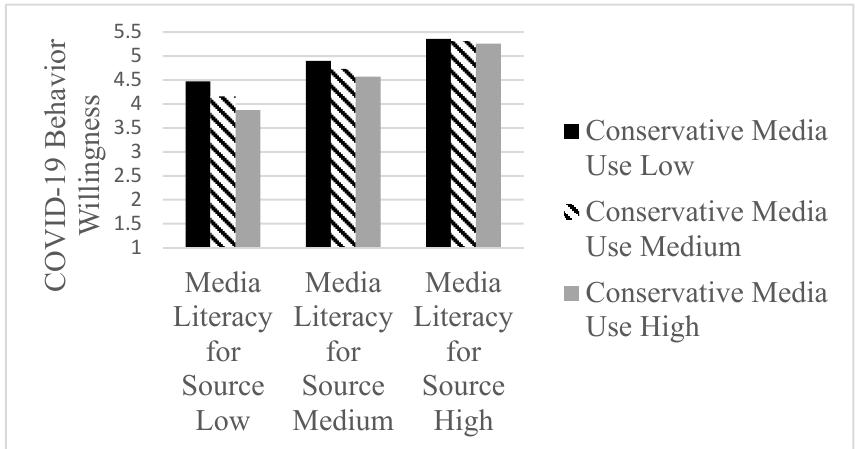
Table 1. Conditional Effects of Conservative Media Use and Media Literacy for Source on COVID- 19 Behavioral Willingness.